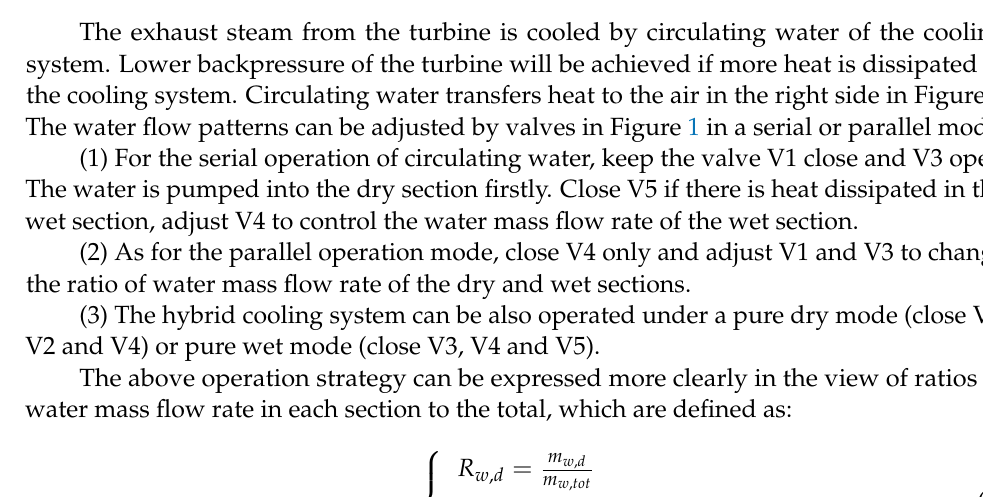
tem. Lower backpressure of the turbine will be achieved if more heat is dissipated in the